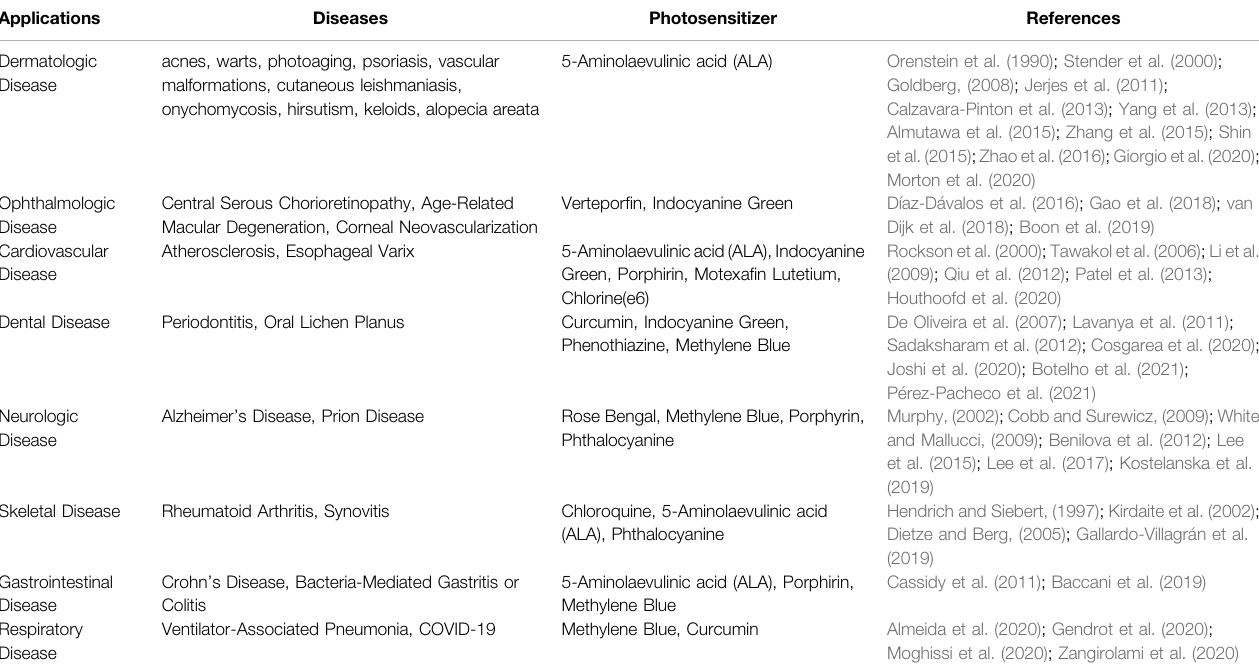
TABLE 2 | Photosensitizers investigated in clinical and preclinical trials for non-cancer diseases treatment.